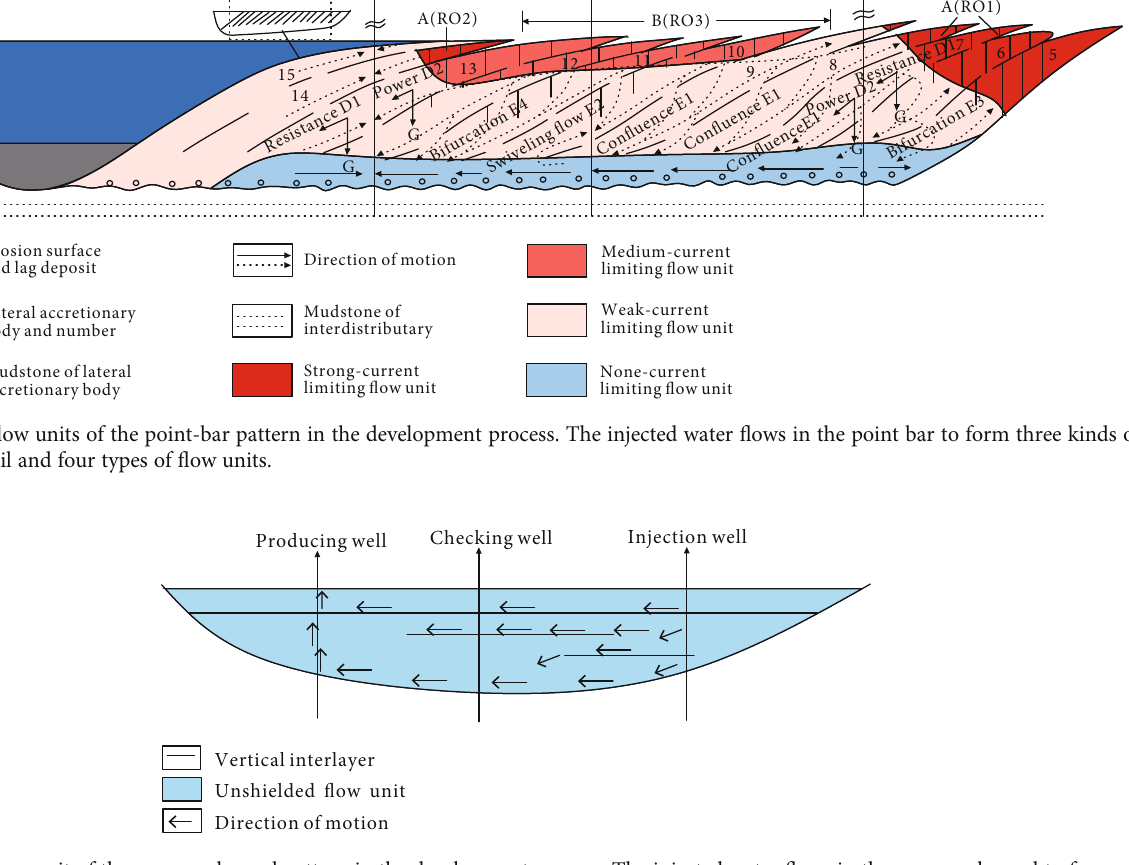
Figure 9: Flow unit of the narrow-channel pattern in the development process. The injected water fl ows in the narrow-channel to form an unshielded fl ow unit.